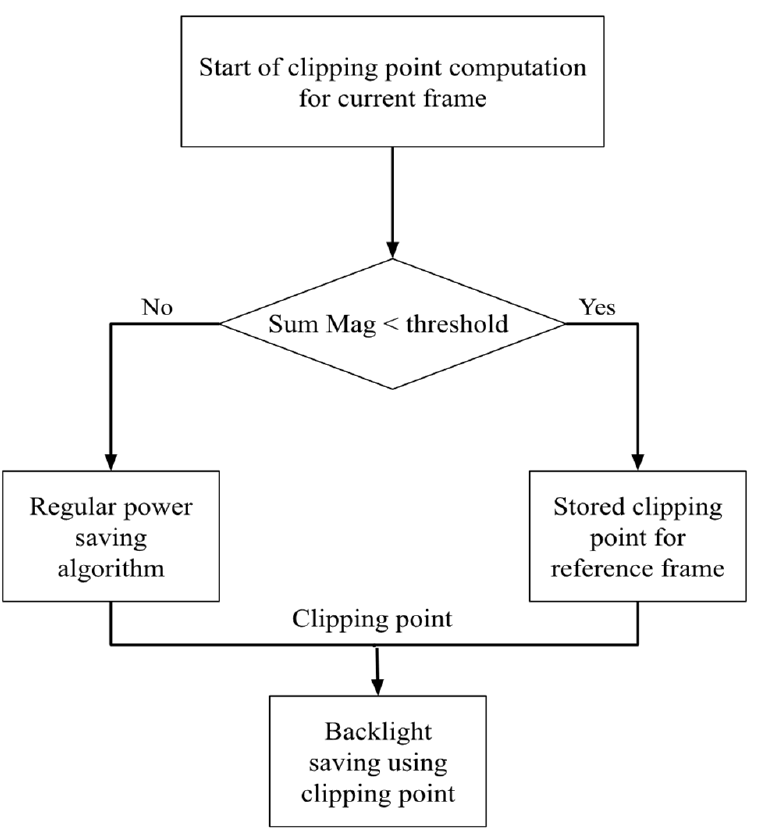
Figure 2. Flow chart of the proposed Figure 2 . Flow chart of the proposed work.